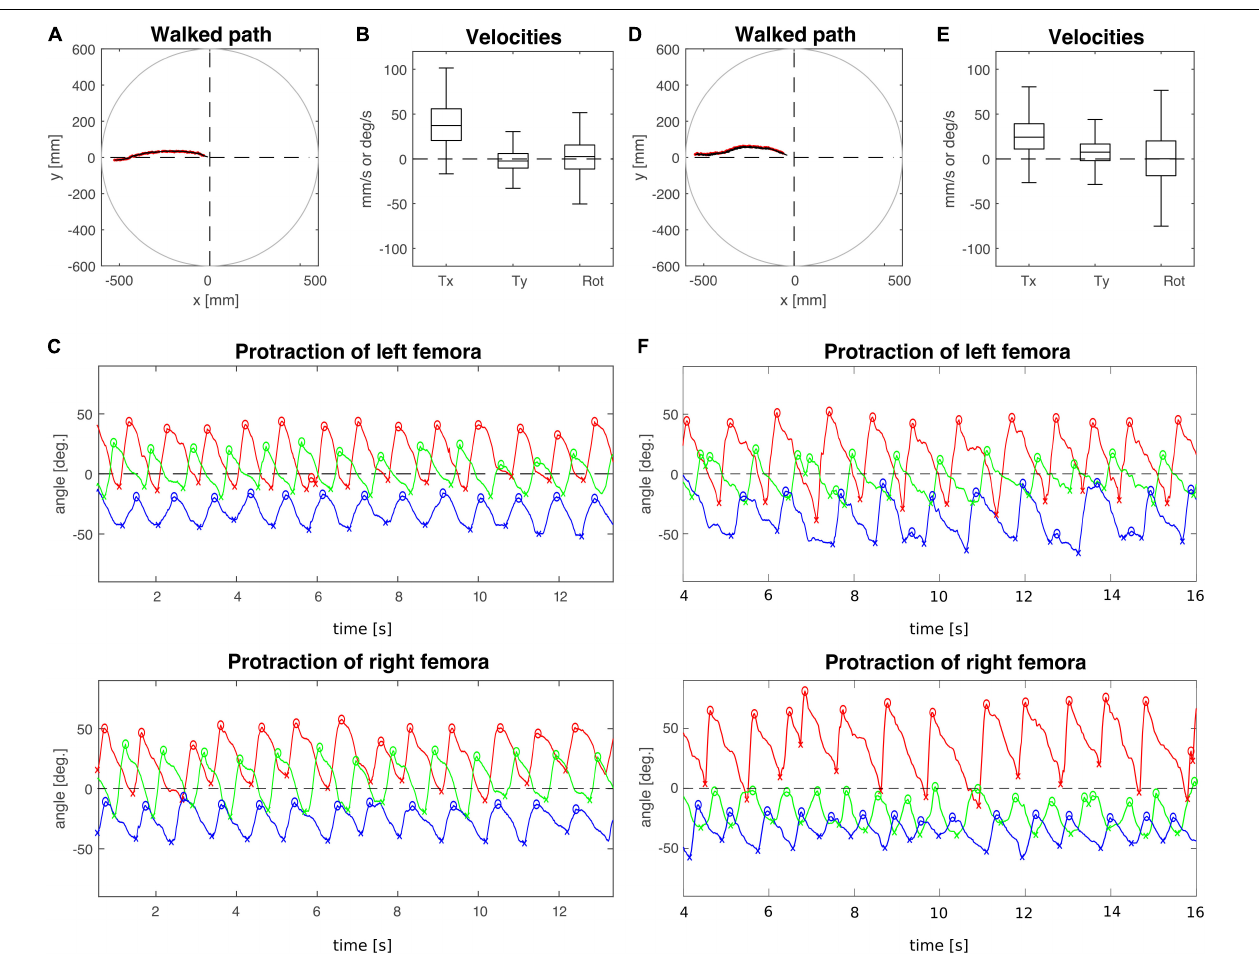
FIGURE 2 | Representative trials of animals that had undergone an operation at the pro-to-mesothorax connective. (A–C) T2 sham operation; (D–F) T2 connective lesion. (A,D) Walked path of the animal in the circular arena. The animal was placed in the centre of the arena facing toward one of four starting directions (here: 180 ◦ , see also Figure 1C ) and walked toward a visual landmark on the arena wall in that same direction. (B,E) Fluctuation of forward (T x ) and sideward (T y ) translational velocities (in mm/s) as well as the rotational velocity about the yaw axis (in deg/s). (C,F) Time courses of protraction/retraction angles of the animals’ front (red), middle (green) and hind legs (blue). Zero degrees (black dashed lines) corresponds to a leg posture orthogonal to the body axis. The anterior and posterior extreme positions are marked by circles and crosses. Note that the time course of the trial shown in (F) was truncated to the same time window as the trial shown in (C) . The complete trial is shown in Supplementary Figure 2